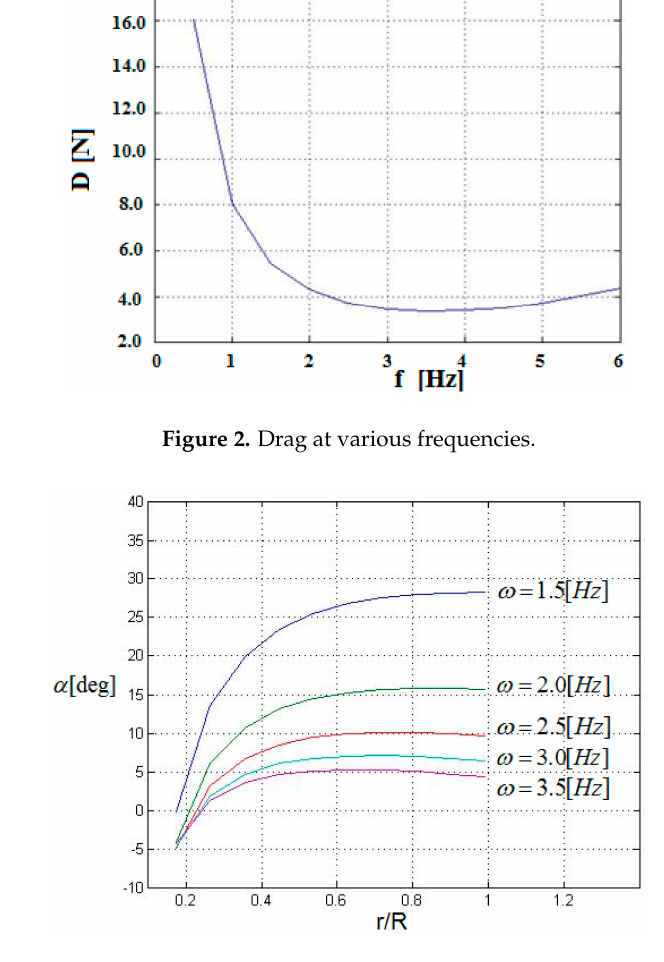
Figure 3. Effective angle-of-attack (AOA) along the wing span.